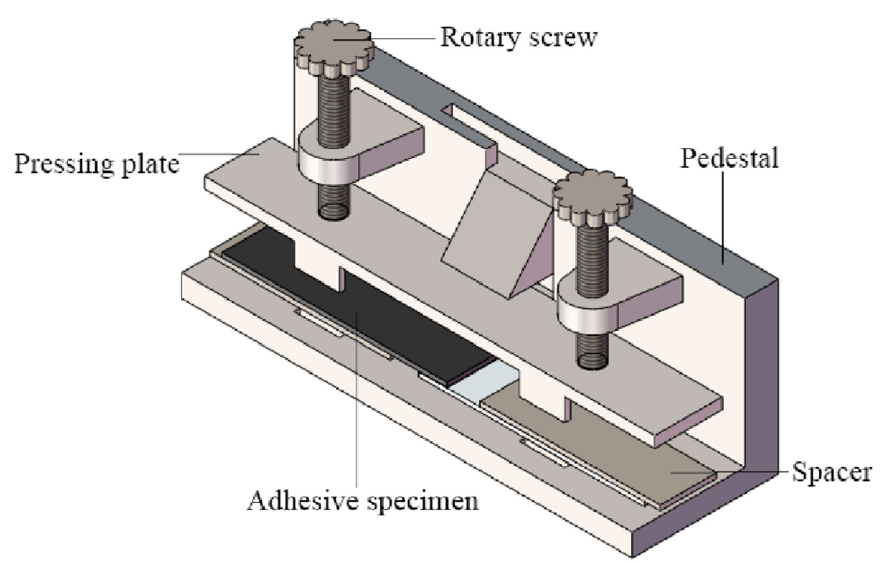
Figure 1. Adhesive fixture of single-lap joint.